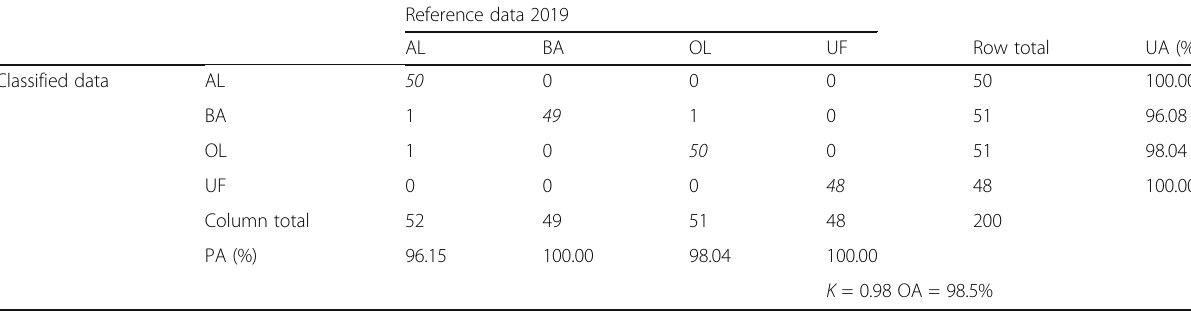
Table 2 Contingency table for the year 2019 classified map